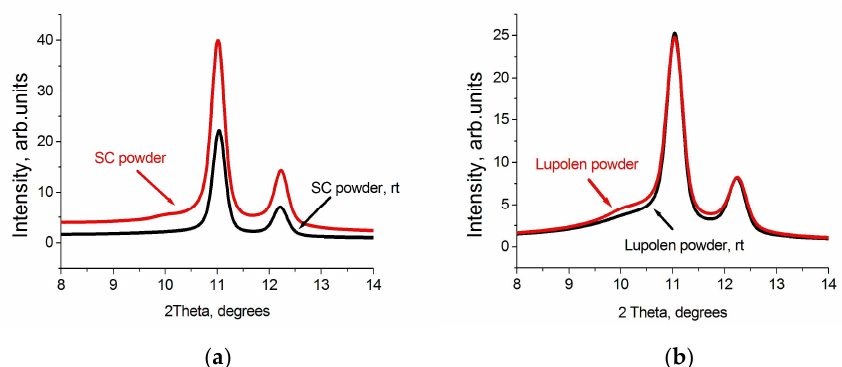
Figure 4. WAXS integrated patterns of SC ( a ) and Lupolen ( b ) individual particles recorded at 300 K (red) and WAXS integrated patterns recorded of the particles first heated from 300 K to 370 K with a step of 5 K, then kept 20 min at this temperature and fast cooled down to 300 K (rt, black).